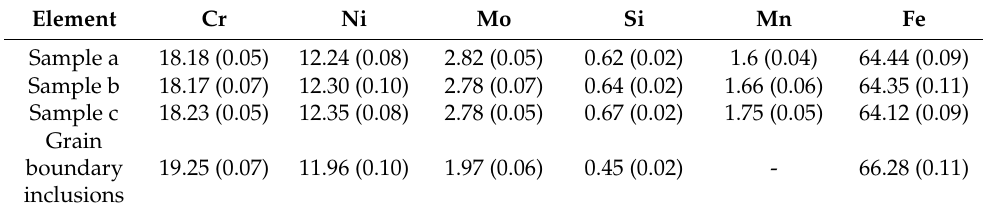
Table 2. EBM-manufactured 316LN stainless steel sample elemental weight percentage and (SD) acquired via EDS. Sample designation a, b, and c referenced from process window presented in Figure 3.